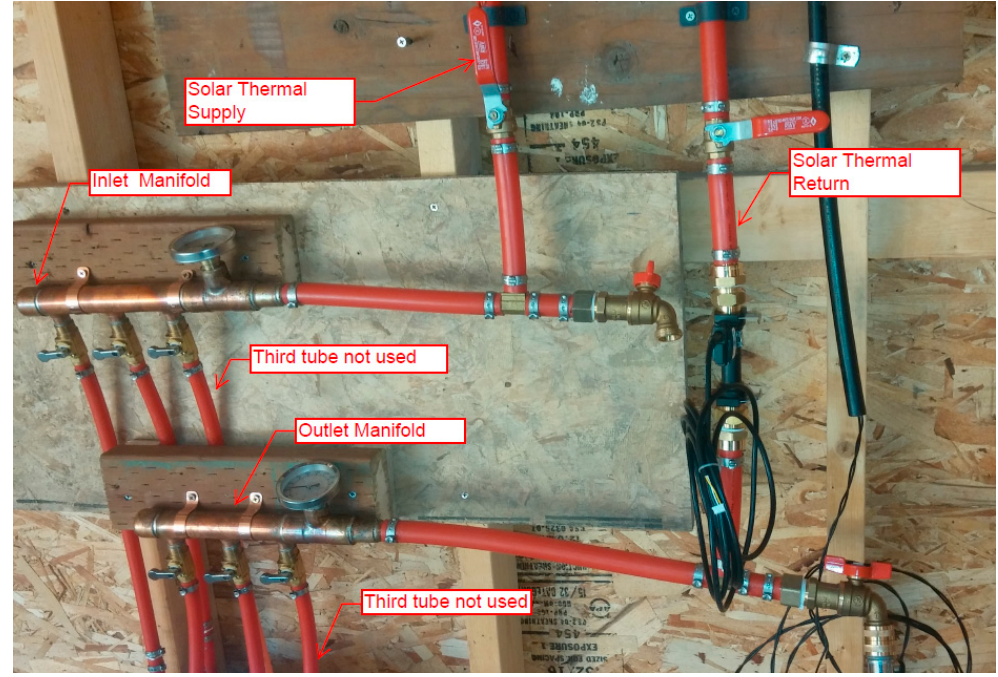
Figure 4. Solar thermal tubing manifold assembly.